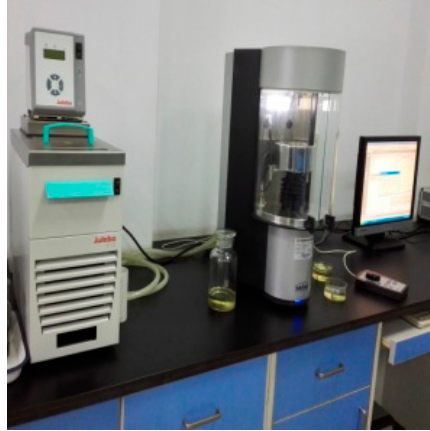
Figure 5. K100 type force tensiometer.